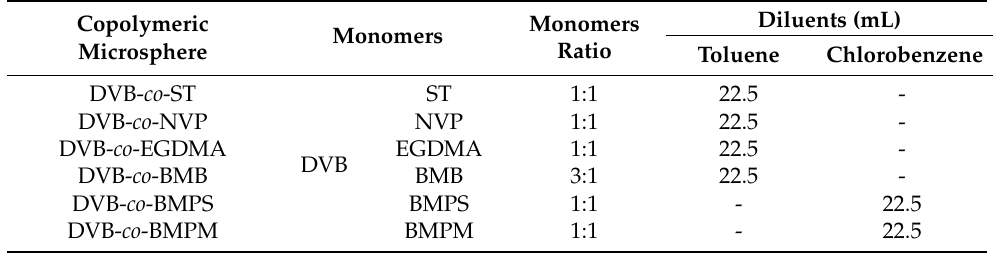
Table 1. Designations and experimental parameters of copolymeric microspheres